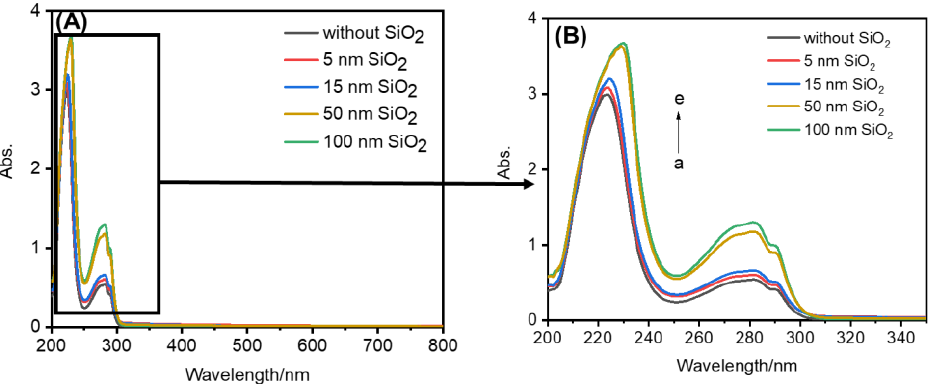
Figure 5. ( A ) UV spectrum from 200 nm to 800 nm. ( B ) UV spectrum from 200 nm to 350 nm. UV spectra of lysozyme solutions with and without SNP. From bottom to top: a, without SNP; b, 0.025 mg/mL 5 nm SNP; c, 0.025 mg/mL 15 nm SNP; d, 0.025 mg/mL 50 nm SNP; e, 0.025 mg/mL 100 nm SNP.